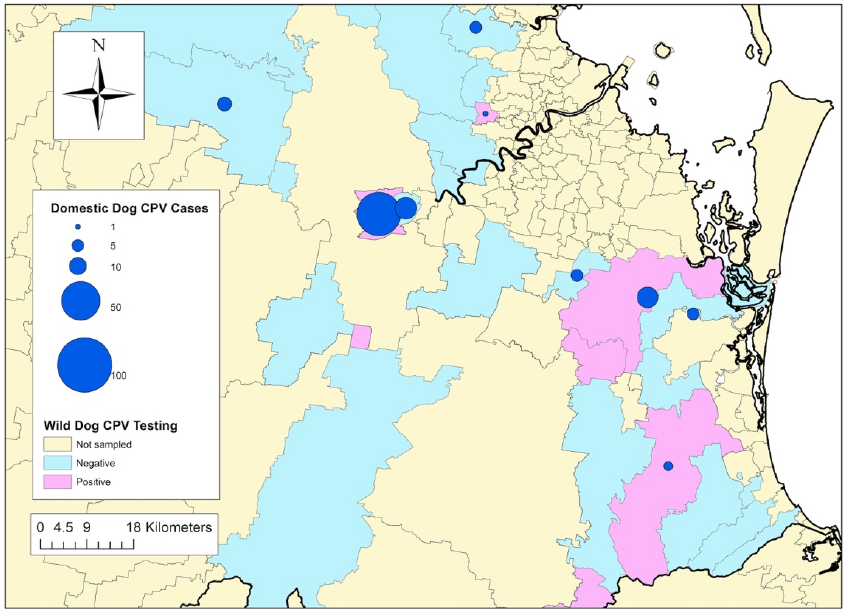
Figure 3. Distribution and frequency of canine parvovirus cases in domestic dogs reported by veterinarians on the Disease WatchDog ® national disease surveillance system between 2009 and 2015, and postcodes where wild dogs, sampled between 2012 and 2015, tested positive or negative for canine parvovirus, as determined by polymerase chain reaction. Map represents Brisbane and south of Brisbane, to the border of Queensland (QLD) and New South Wales (NSW), Australia.